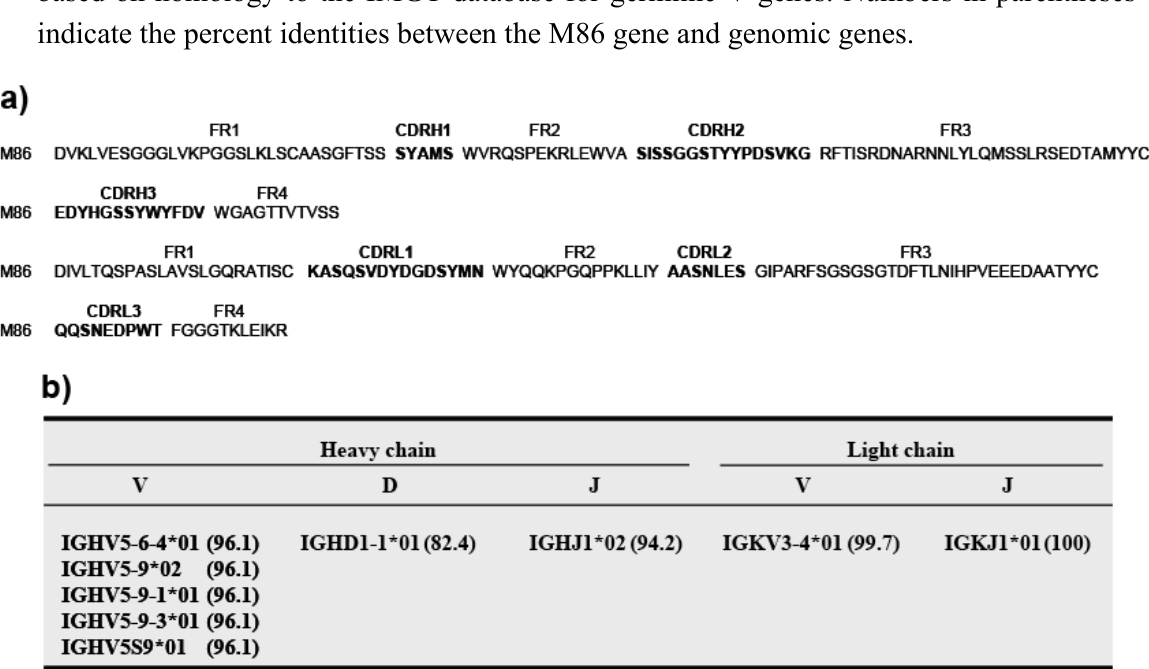
Figure 3. M86 amino acid sequences and gene usage. ( a ) Amino acid sequences for the VH and VL domains. DNA sequences were translated to amino acid sequences using Genetyx ver. 8. CDR1–CDR3 and FR1–FR4 were deduced according to Kabat and Wu [24]. CDR regions are indicated in bold. ( b ) Gene usage. Germline gene usage was assigned based on homology to the IMGT database for germline V genes. Numbers in parentheses indicate the percent identities between the M86 gene and genomic